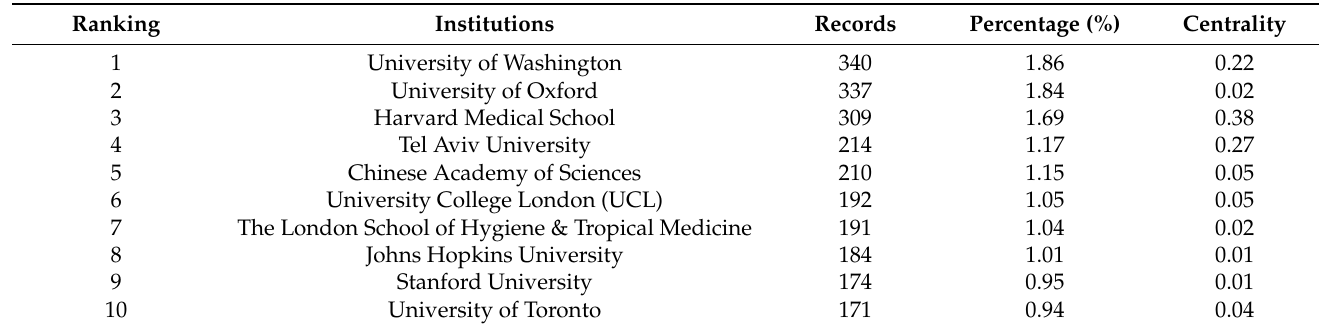
Table 2. Top 10 most prolific institutions on COVID-19 vaccine research.